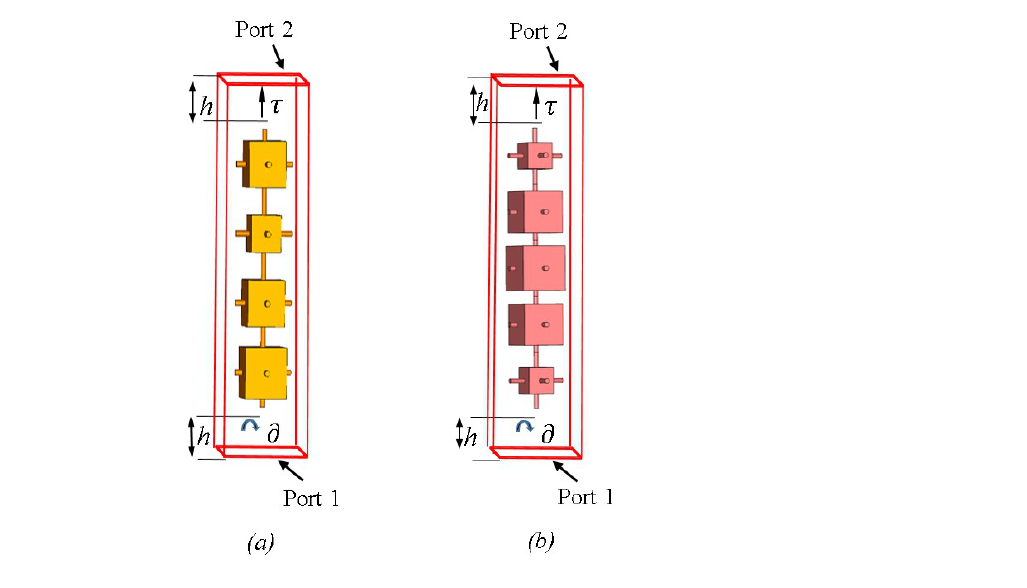
Figure 1. Unit cell arrangement with a two-port network: ( a ) four-layer ( b ) five-layer.